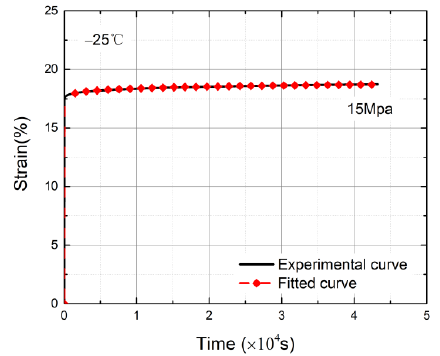
Figure 9. Curve fitting under a loaded stress level of 15 MPa at T = − 25 °C. The parameters of the curve fitting are shown in Table 2. Table 2. Curve fitting parameters.